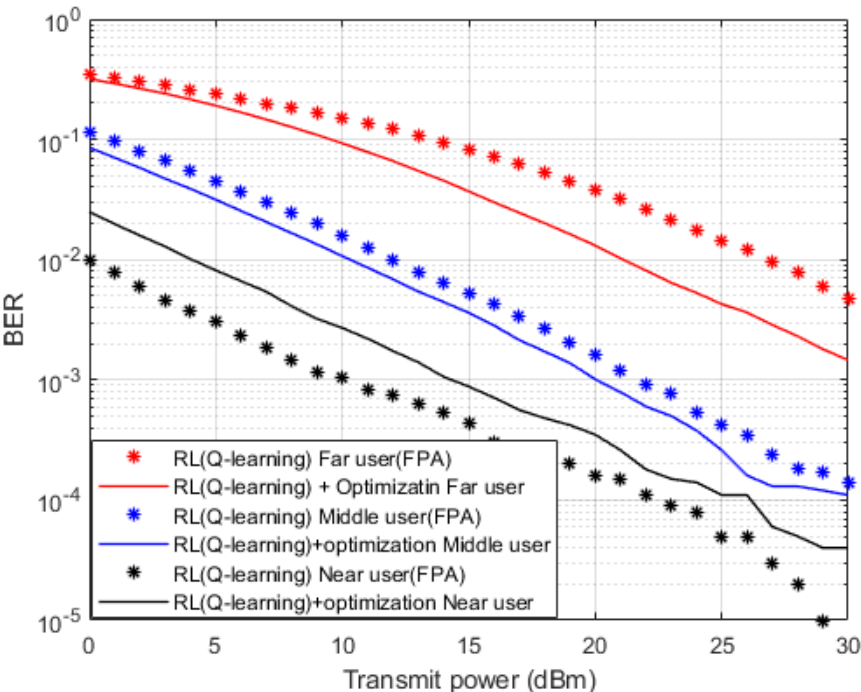
Figure 13. BER vs. Power ( Q ‐ learning, Optimization, FPA).